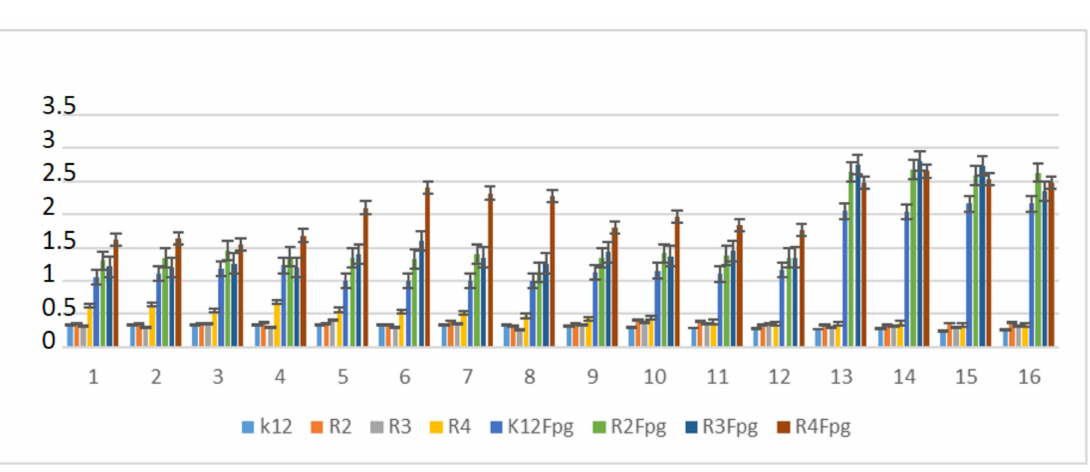
Figure 9. Percentage of plasmid DNA recognized by Fpg enzyme after ciprofloxacine (value 1–4), kanamycine (value 5–8), streptomycine (value 9–12), and bleomycine treatment (value 13–16). The compounds were statistically significant at < 0.05